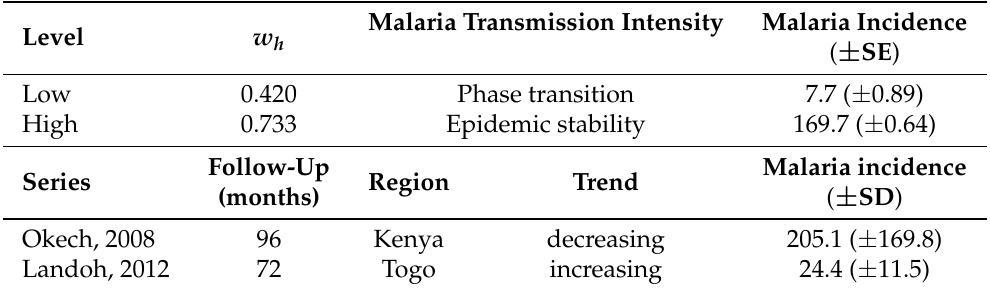
SE) of ten simulations in all settings. ( Bottom ) Em- ± SD) in different settings of malaria ±